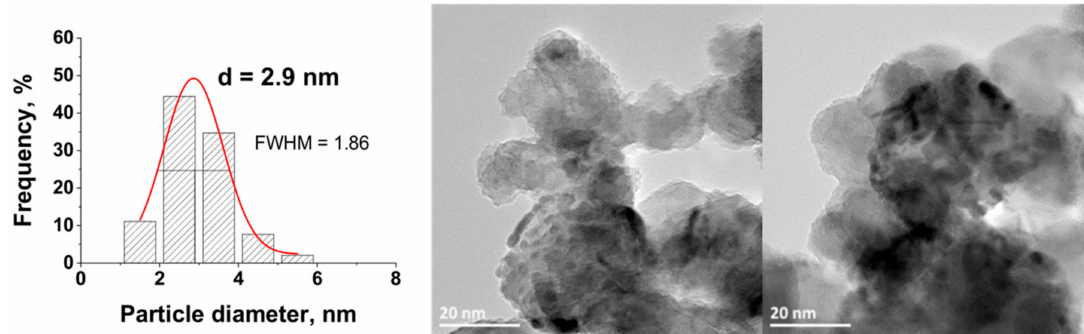
Figure 8. TEM image and the Ru nanoparticle size distribution for the Ru(5 wt.%)/TiO 2 -P25 catalyst prepared via classical impregnation with final reduction in hydrogen at 200 ◦